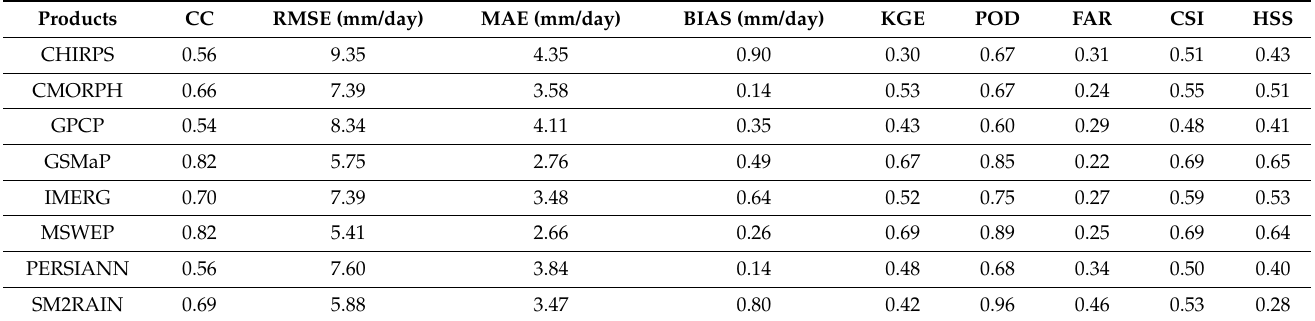
Table 3. Summary of the overall annual mean of statistical metrics (from 2007 to 2020) evaluating eight satellite precipitation products at the watershed